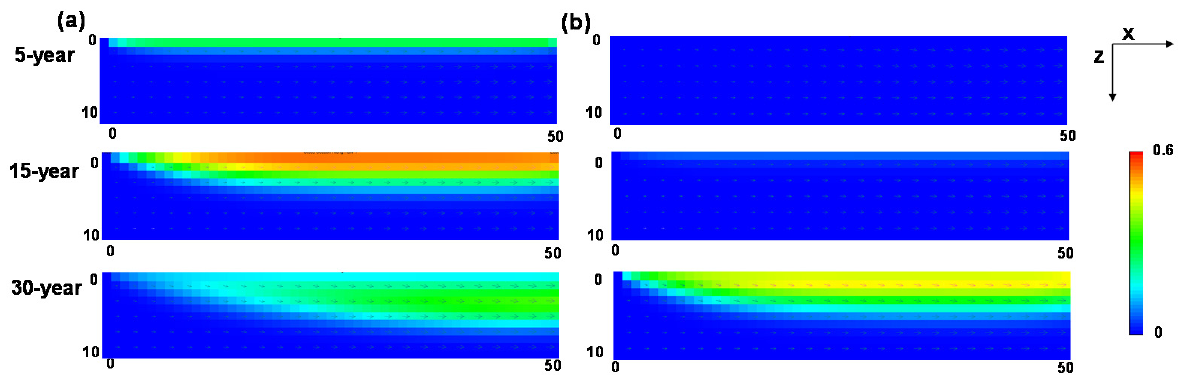
Figure 8. Model simulated results for the fate and transport of benzene in the saturated aquifer for ( a ) L = 1 m and D = 5 m, ( b ) L = 5 m and D = 1 m.